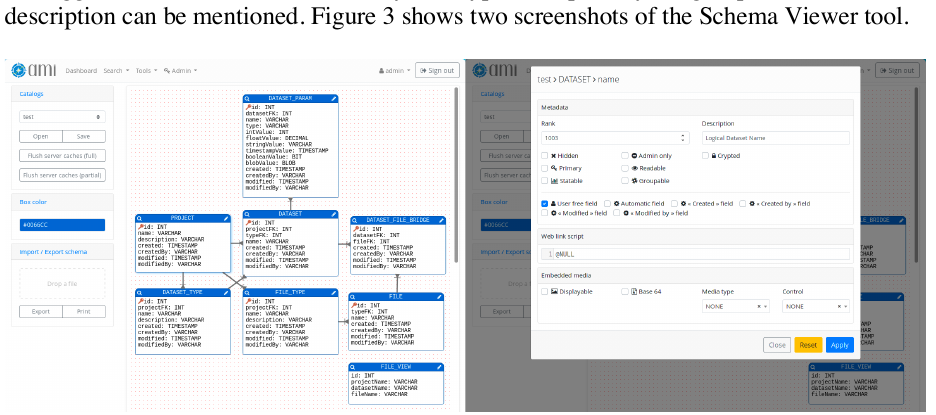
Fig 3. Screenshot of the AMI Schema Viewer. Visualisation of a database schema (at left) and all the additional metadata associated to the field `test`.`DATASET`.`name` (at right).